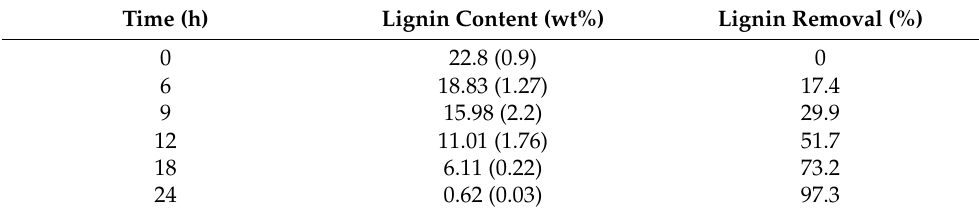
Table 1. The relationship between lignin removal and treatment